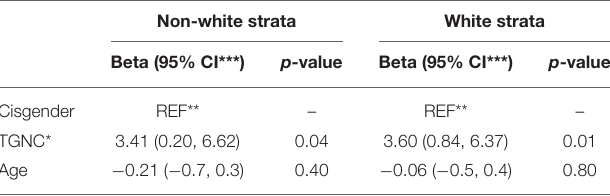
TABLE 4 | Multivariable analysis of gender identity, mental health distress and age, and stratified by race. Non-white strata White